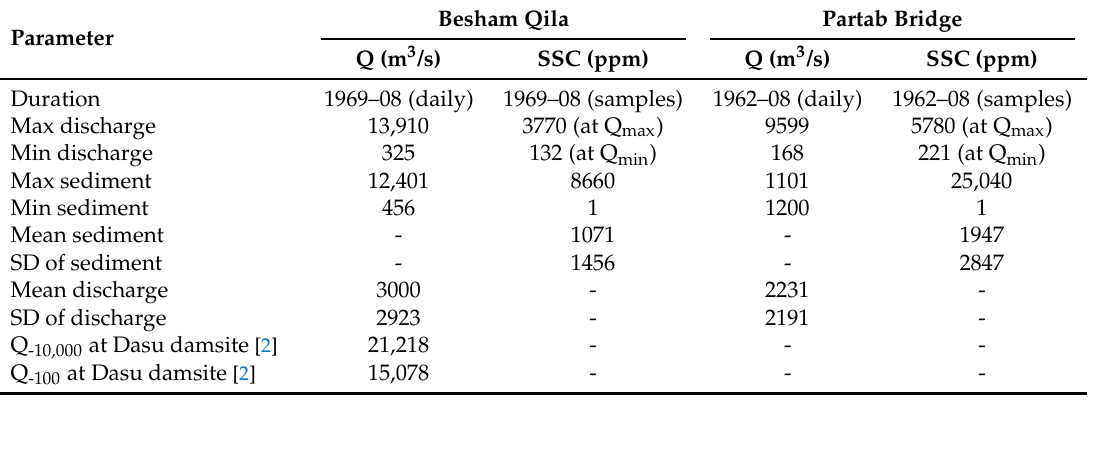
Table 2. Hydrological and sedimentological characteristics at the Besham Qila and the Partab Bridge gauges.